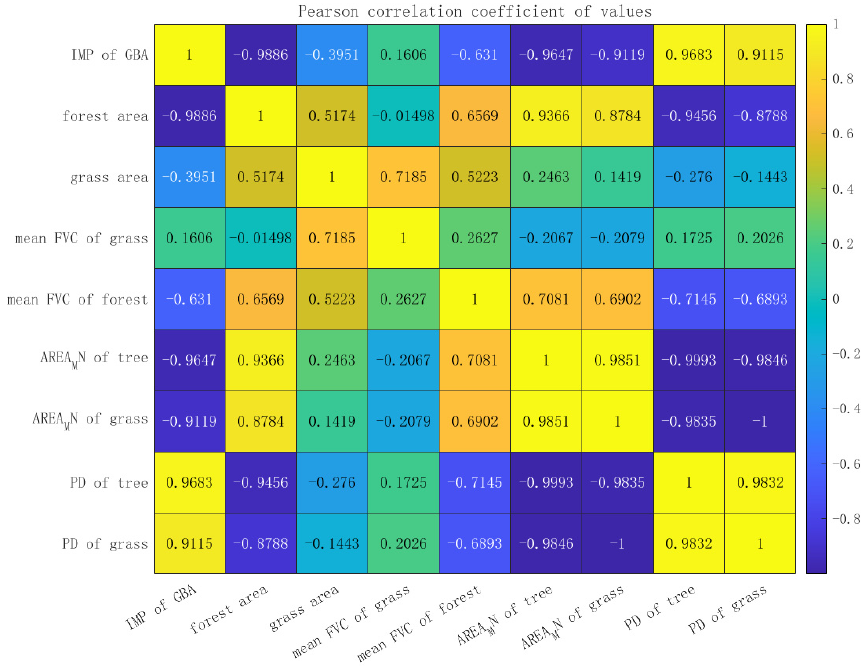
Figure 11. Vegetation coverage of forest in different years. ( a ) In 1990; ( b ) In 2000; ( c ) In 2005; ( d ) In 2010; ( e ) In 2020.